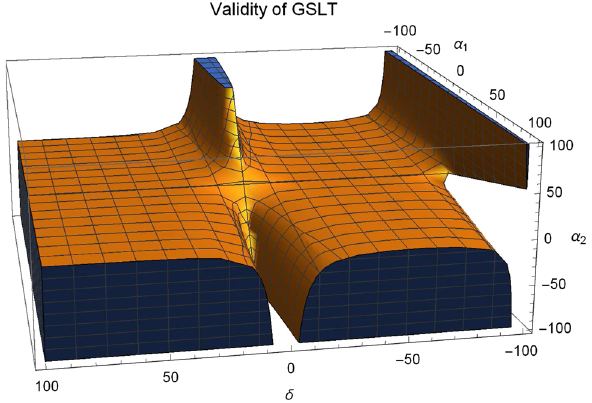
Fig. 12 Plot represents the validity regions of GSLT (52) for equilib- rium case in terms of cosmographic